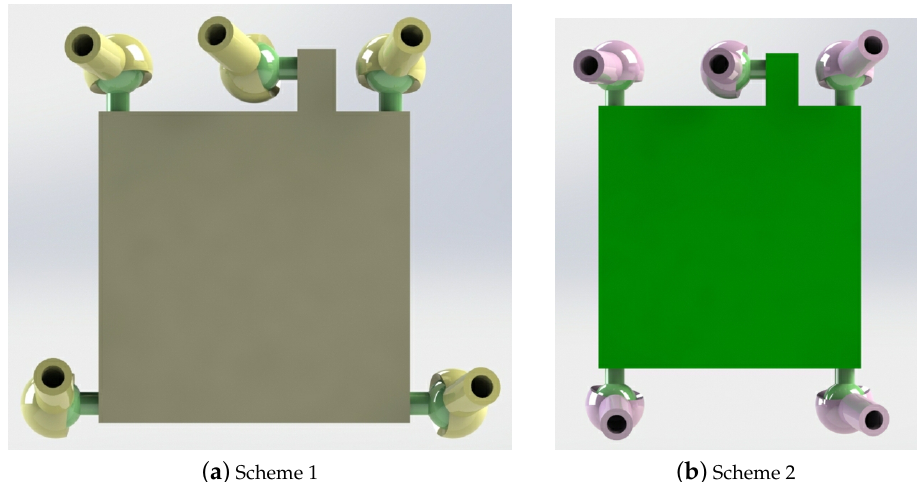
Figure 14. Distribution of spherical hinges on the moving platform.